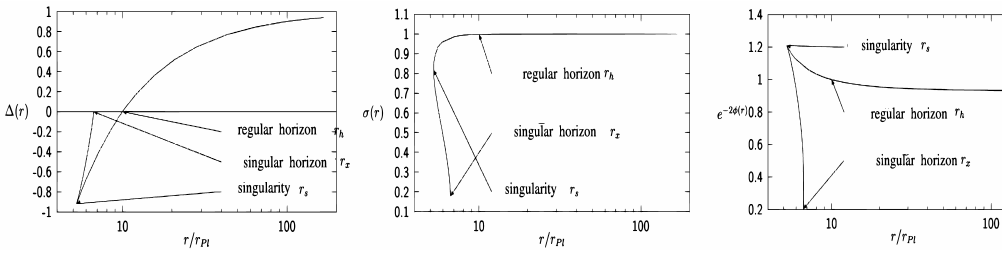
Figure 1. Dependence of the metric functions ∆ , σ and the dilatonic exponent e − 2 φ against the radial coordinate r . Reproduced from